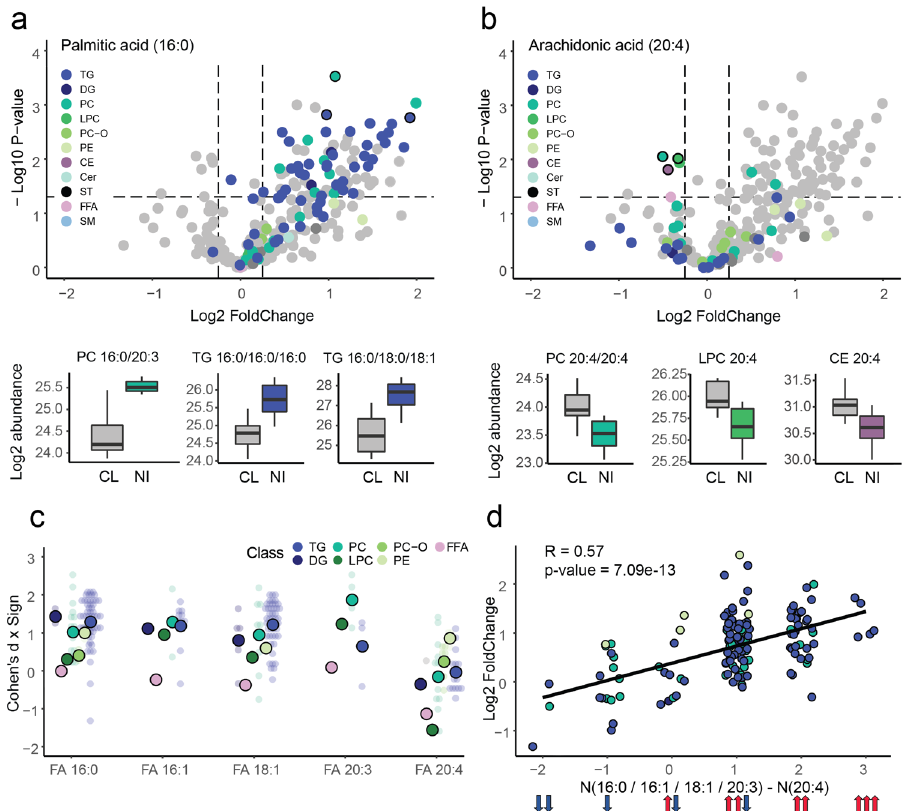
Figure 3. Interaction between the lipid classes and fatty acids most affected by NI. ( a ) Palmitic-acid- containing lipids. Top: volcano plot for ANOVA test between NI and CL, where lipids containing palmitic acid (16:0) are colored according to their respective lipid class. Lipids annotated at the fatty acid level but not containing palmitic acid are colored in gray. The three palmitic-acid-containing lipids with the lowest p -values (excluding isomers) are marked by black edges. Bottom: for these three lipids, box plots of the distributions of log2 abundances in NI and CL. ( b ) Same for arachidonic acid (20:4). ( c ) Fatty acid effects separated by lipid class. Distribution of signed Cohen’s d values for lipids containing fatty acids 16:0. 16:1, 18:1, 20:3, and 20:4, separated by lipid class (indicated by color). Smaller points correspond to a lipid, whereas bold points represent mean values for each class. ( d ) Additive effect of fatty acid residues. For a particular lipid, the number of fatty acids with negative direction of effect in NI (20:4) is subtracted from the number of fatty acids with positive direction (16:0, 16:1, 18:1, or 20:3), which is indicated on the x -axis, while its log2 fold changes between NI and CL is indicated on the y-axis. A linear regression was used to visualize the relationship, with correlation coefficient and corresponding p -value marked on the plot. The colored arrows illustrate examples of combinations of fatty acid residues with particular directions of effect in NI. All lipid classes with two or three fatty acid residues (excluding PI, n = 2) were considered in this analysis, i.e., PC, PE, DG, and TG. Moreover, only lipids including at least one of the affected fatty acids (16:0, 16:1, 18:1, 20:3, or 20:4) were included in the